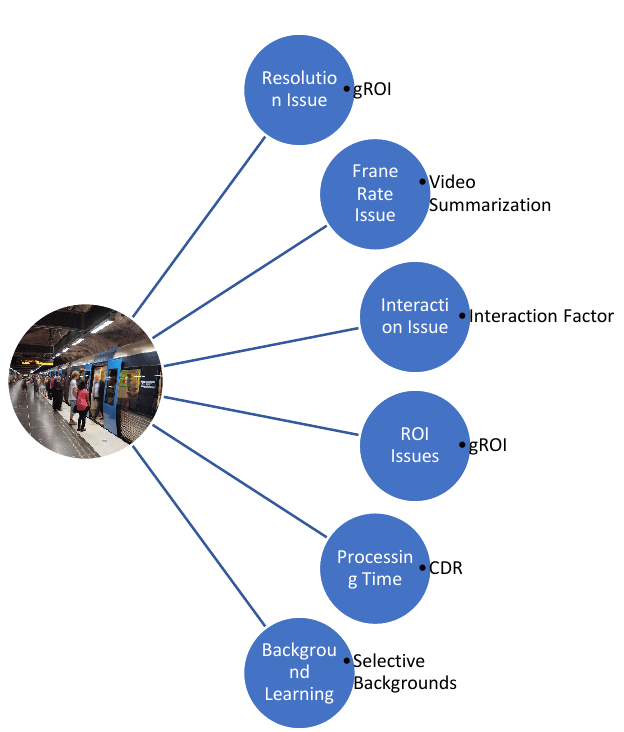
Figure 3. Identified Key-Predictors on the issues.